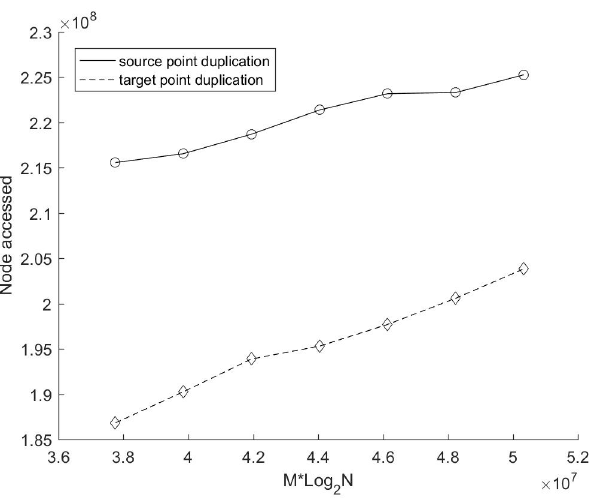
Figure 7. Node accessed during the search process with different number of source points.